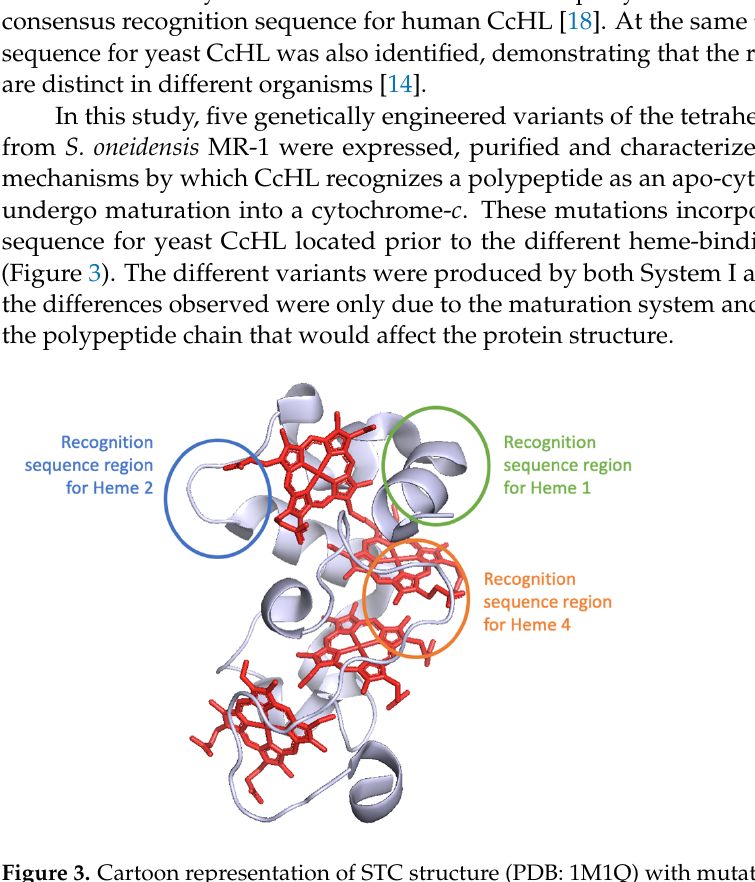
Figure 3. Cartoon representation of STC structure (PDB: 1M1Q) with mutated regions highlighted with colored circles. with colored